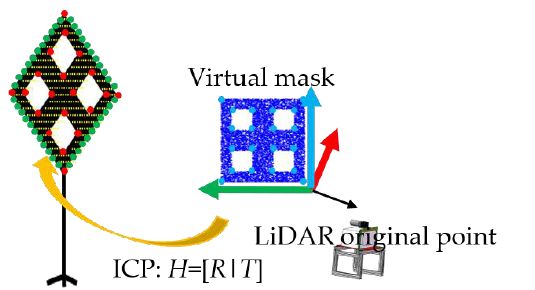
Figure 6. Schematic diagram of virtual mask matching. Red points represent the 3D feature points we need, green points represent the refined edge points, and blue points are generated for matching.